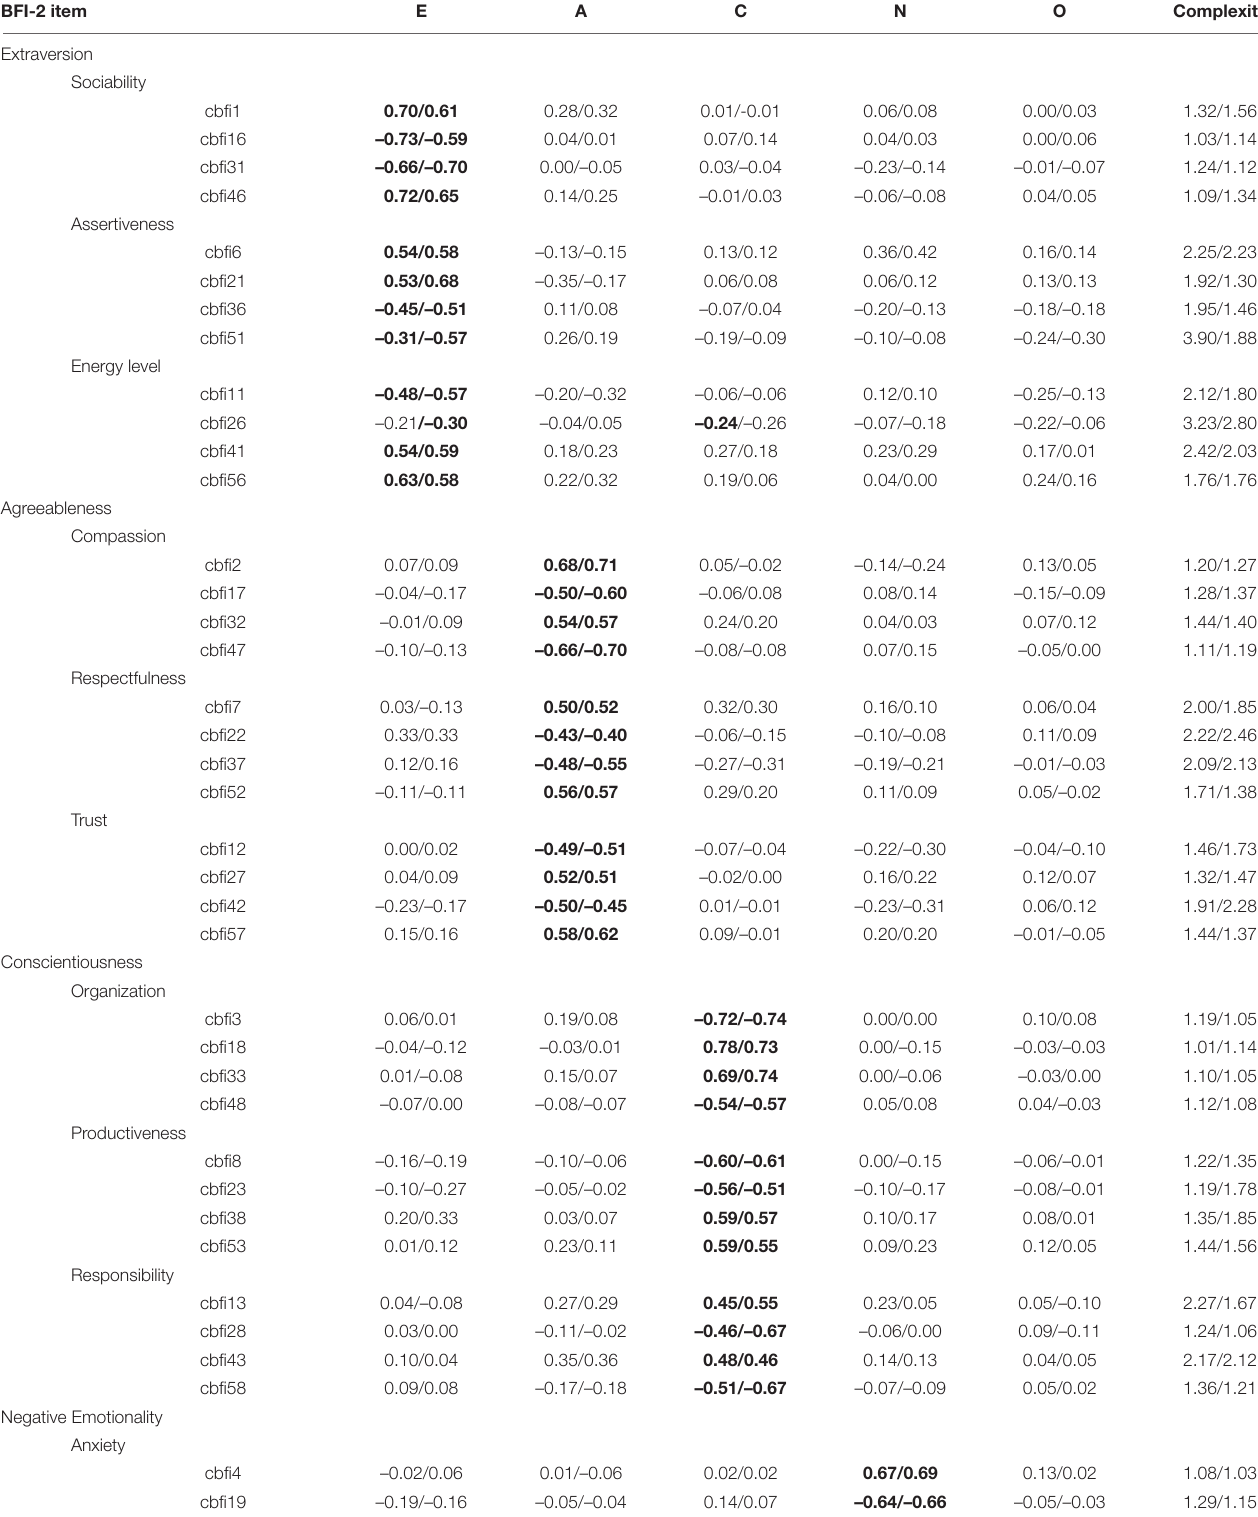
TABLE 1 | Loadings from a principal component analysis of the 60 within-person centered Norwegian BFI-2 items (Study 1 and